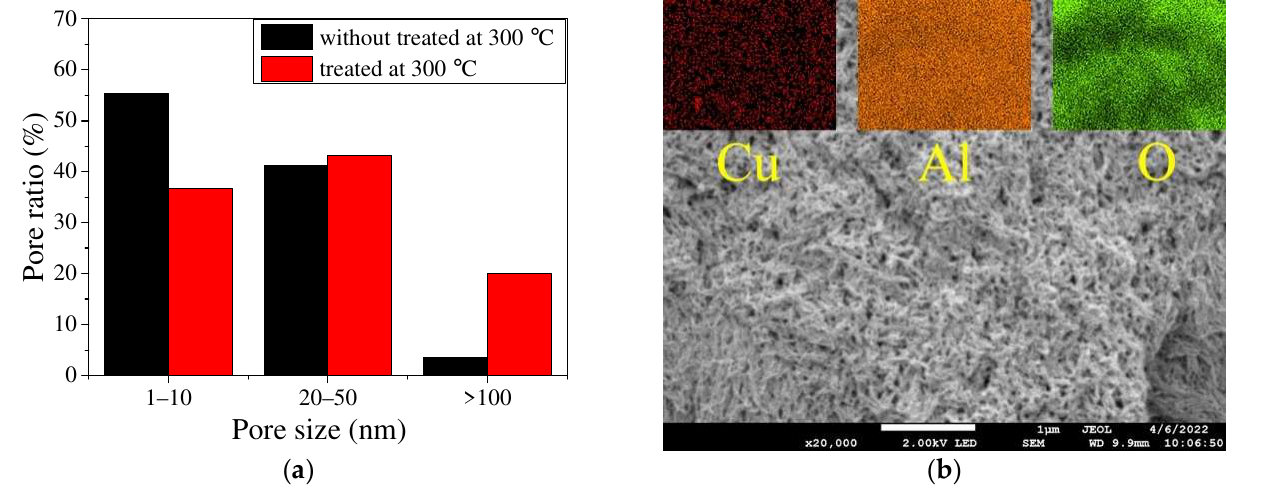
Figure 2. ( a ) Pore size and ( b ) element distribution of Cu 2 O/Al 2 O 3. Compared with amorphous Cu (I) oxide, crystalline Cu (I) oxide has better catalytic activity; however, Cu (I) oxide nanoparticles obtained by electrochemical deposition tech- nology are amorphous. To transform amorphous Cu (I) oxide into a crystalline structure, samples were heated at 300 ◦ C with an anodic current density of 50 mA/cm 2 , a reaction temperature of 4 ◦ C for 40 min in a 10 wt.% H 2 SO 4 solution. Samples were prepared with and without the coating via electrochemical deposition for 30 min, and were heated at 300 ◦ C. Their XRD spectra are shown in Figure 3. Before the Al 2 O 3 and Cu 2 O/Al 2 O 3 coatings were heated at 300 ◦ C, their XRD spectra were smooth curves, illustrating that the coatings were composed of amorphous components. When the coatings were heated at 300 ◦ C, obvious characteristic peaks appeared [44], which proved the amorphous Cu (I) oxide and Al 2 O 3 were transformed into crystalline structures. At 44.3 ◦ , 45.4 ◦ and 66.6 ◦ , there were Al 2 O 3 characteristic peaks in the XRD spectra of the Al 2 O 3 and Cu 2 O/Al 2 O 3 coatings, while at 38.2 ◦ , 77.9 ◦ and 85.1 ◦ , there were Cu 2 O characteristic peaks in the XRD spectra of the Cu 2 O/Al 2 O 3 coating, but not in the Al 2 O 3 coating. This shows that amor- phous coatings could be transformed into crystalline Cu 2 O/Al 2 O 3 coatings by anodizing, electrochemical deposition, and the heating